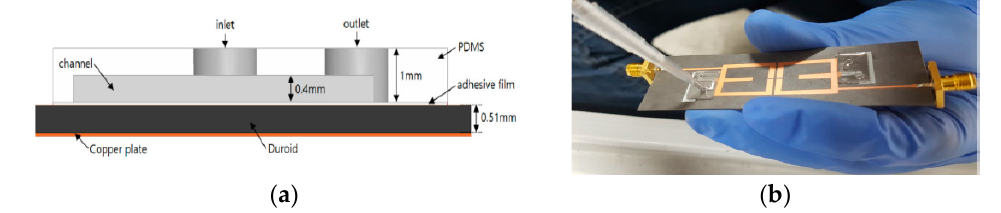
Figure 8. ( a ) Side view of the final filter; ( b ) pictures of the proposed prototype filter injecting EGaIn into the filter [29].